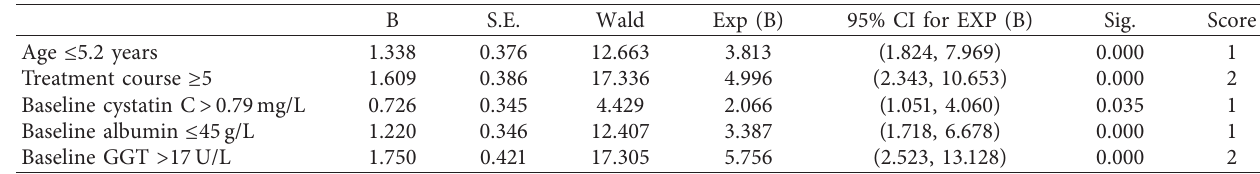
Table 4: Variables in the equation for prediction of DILI in SR/IR